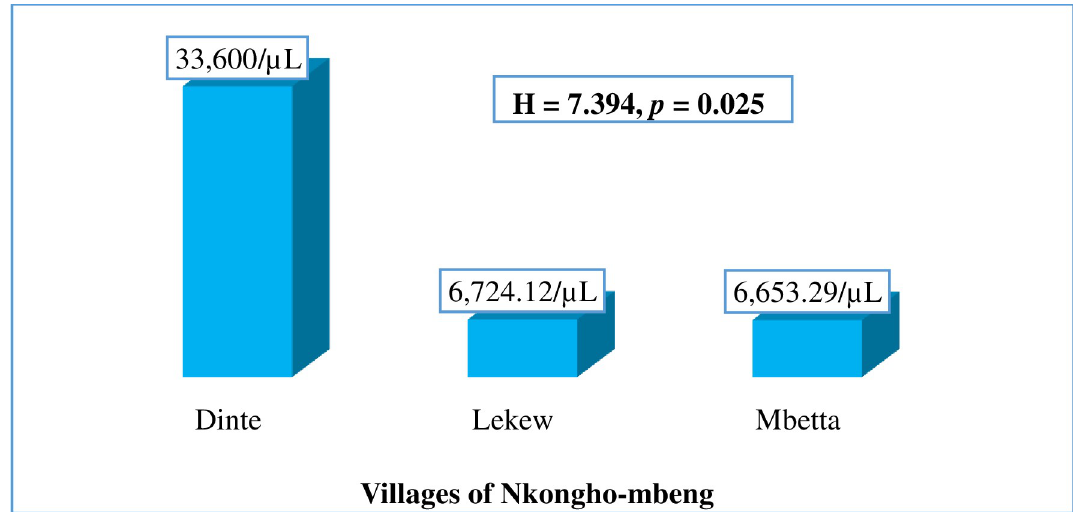
Fig 7. Geometric mean parasite density of malaria with respect to villages